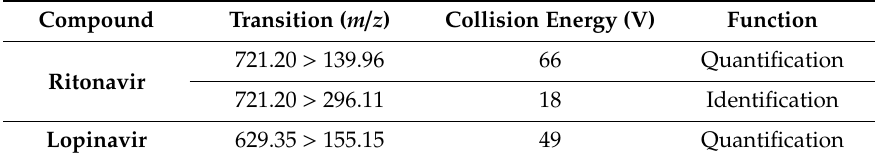
Table 3. MS / MS parameters for the analysis of ritonavir in plasma